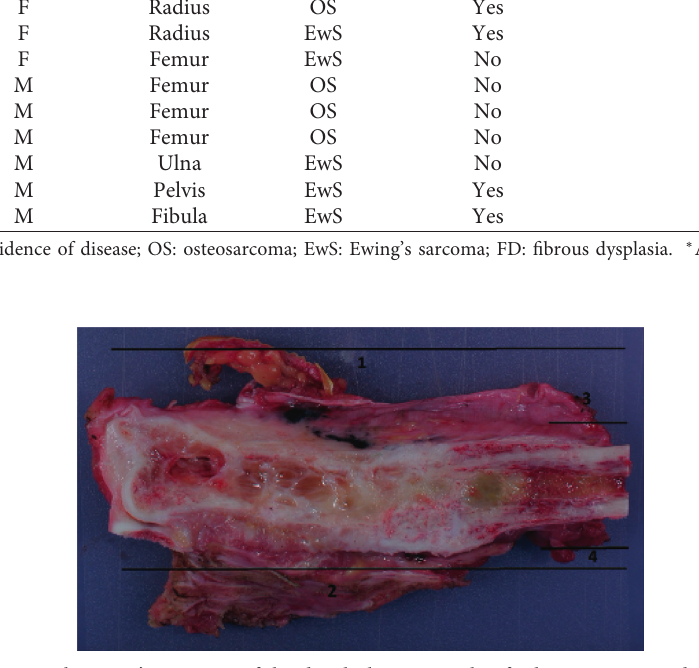
Figure 1: A 36-year-old patient with Ewing’s sarcoma of the distal ulna. Example of schematic oriented representation of margins to be measured. The corresponding MRI slices (created by MPR) were given for measures.